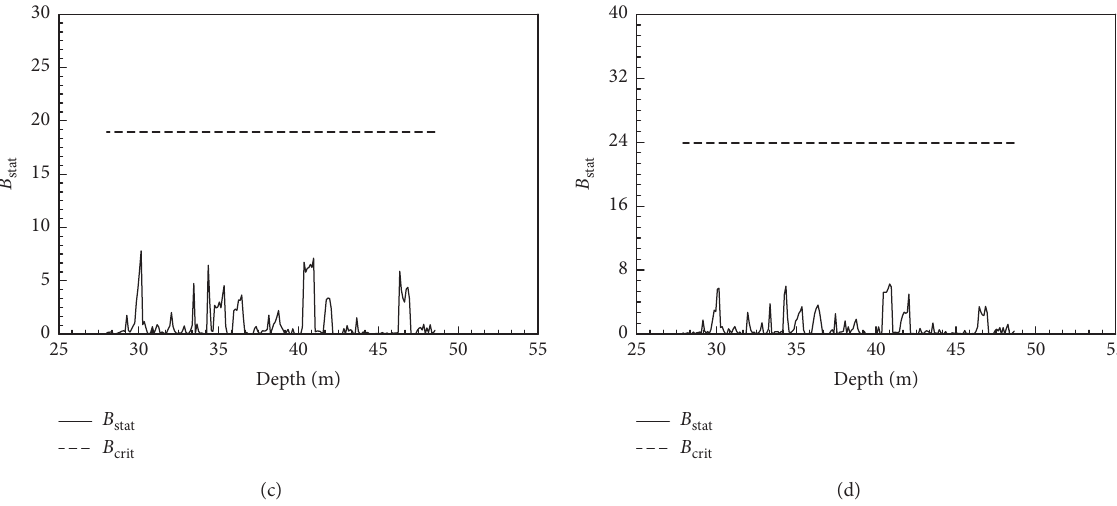
1 . (b) M 2 . (c) M 3 . (d) M 4 .